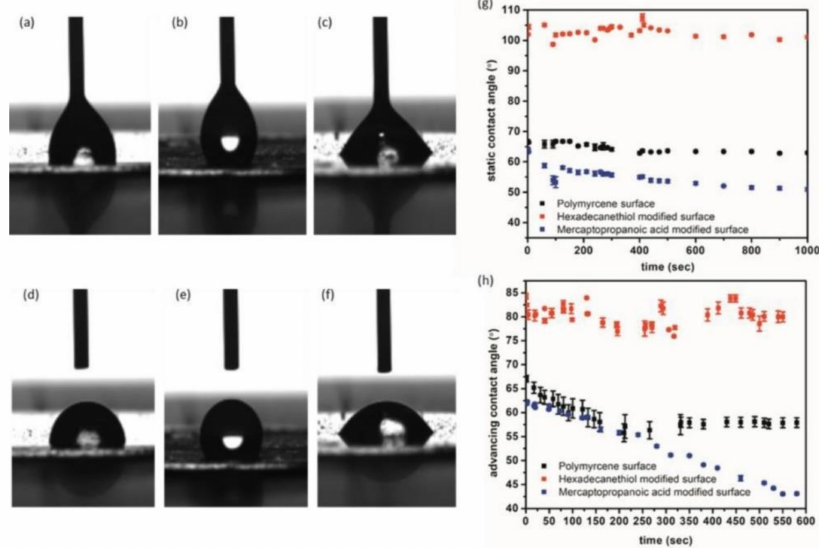
Figure 13. Goniometry comparisons of polymyrcene surfaces before ( a , d ) and after functionalization using hexadecanethiol ( b , e ) and mercaptopropanoic acid ( c , f ), corresponding to static ( g ) and advancing ( h ) contact angles. (Reproduced from Reference 16, with permission from American Chemical